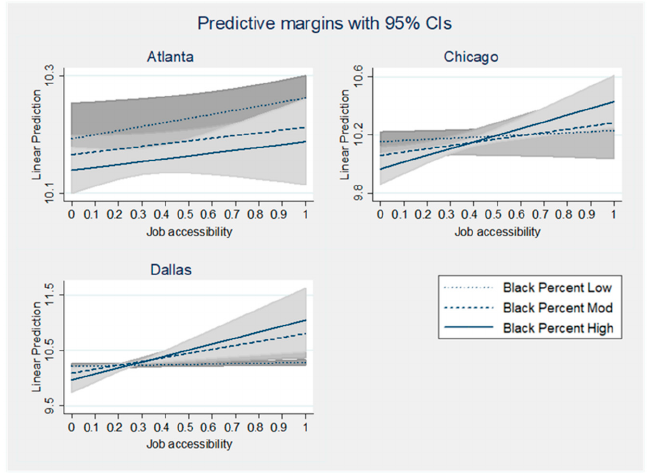
Figure 4. Predictive margins of log income over neighborhood Black share with 95% confidence